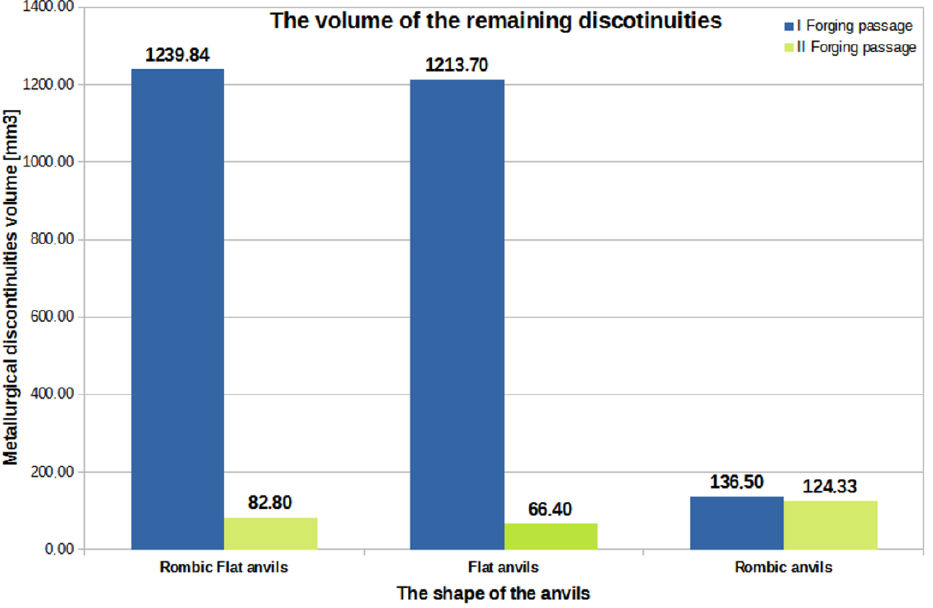
Figure 15. Graph of the total volume of unwelded discontinuities in the volume of a forged zirconium alloy rod for two forging transitions in relation to individual anvil compositions.